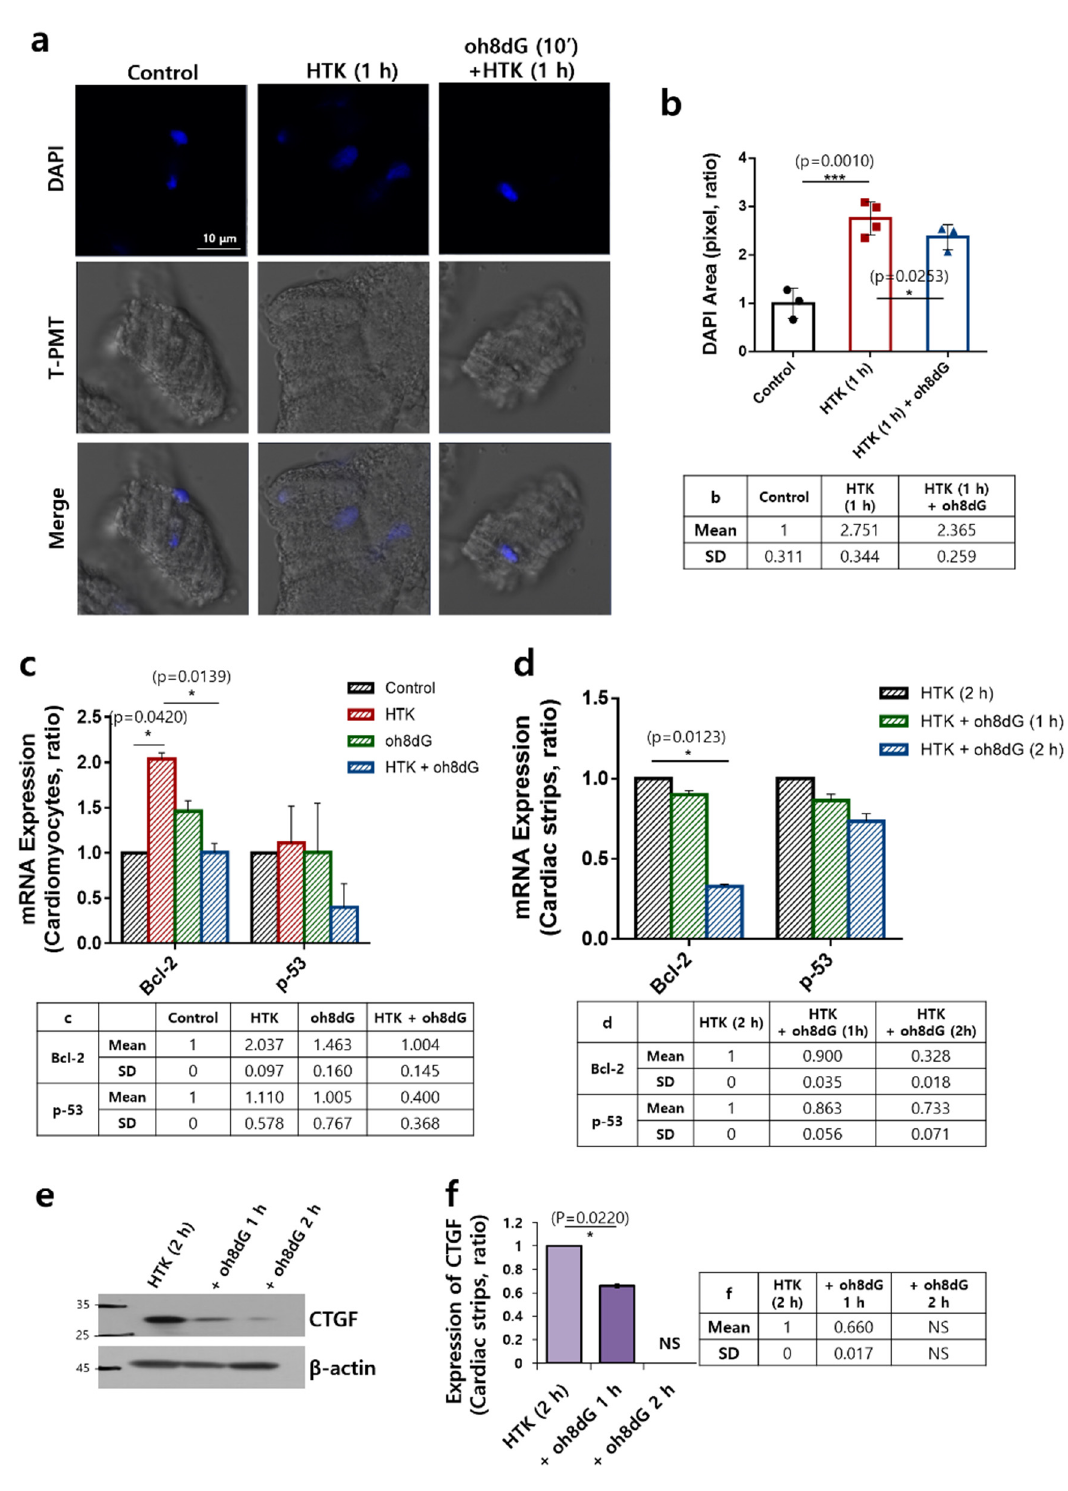
Figure 4. Treatment of oh8dG attenuated DNA fragmentation and expression of the apoptotic marker in HTK-exposed cardiac tissues. ( a ) DAPI (nucleus, blue) staining and T-PMT (gray) of isolated cardiomyocytes in pre-incubation of HTK solution for 1 h and 100 μ g/mL oh8dG for 10 min. The scale bar represents 10 μ m. ( b ) Analysis of total intensity of DAPI. Bars present mean ± SEM ( n = 3, * p < 0.05 and *** p < 0.001). The table represents mean and SD value. ( c ) mRNA expression of Bcl-2 and p-53 in HTK-treated cardiomyocytes for 5 min in the absence and presence of pre-incubation of 100 μ g/mL oh8dG for 1 h on ice. The bars present mean ± SEM ( n = 3, * p < 0.05). The table represents mean and SD value. ( d ) mRNA expression of Bcl-2 and p-53 in HTK-treated cardiac strips